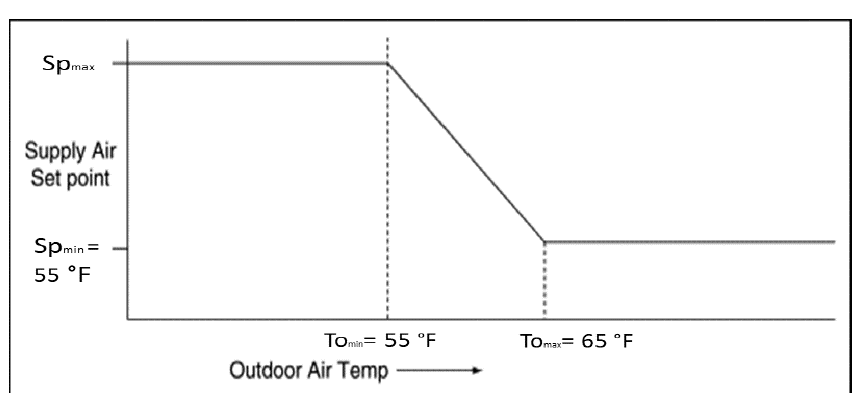
Figure 8. Supply air temperature as a function of outside air temperature. The equation used to describe that linear relation and find the supply air temperature based on the outside air temperature is shown in Equation (5) below.